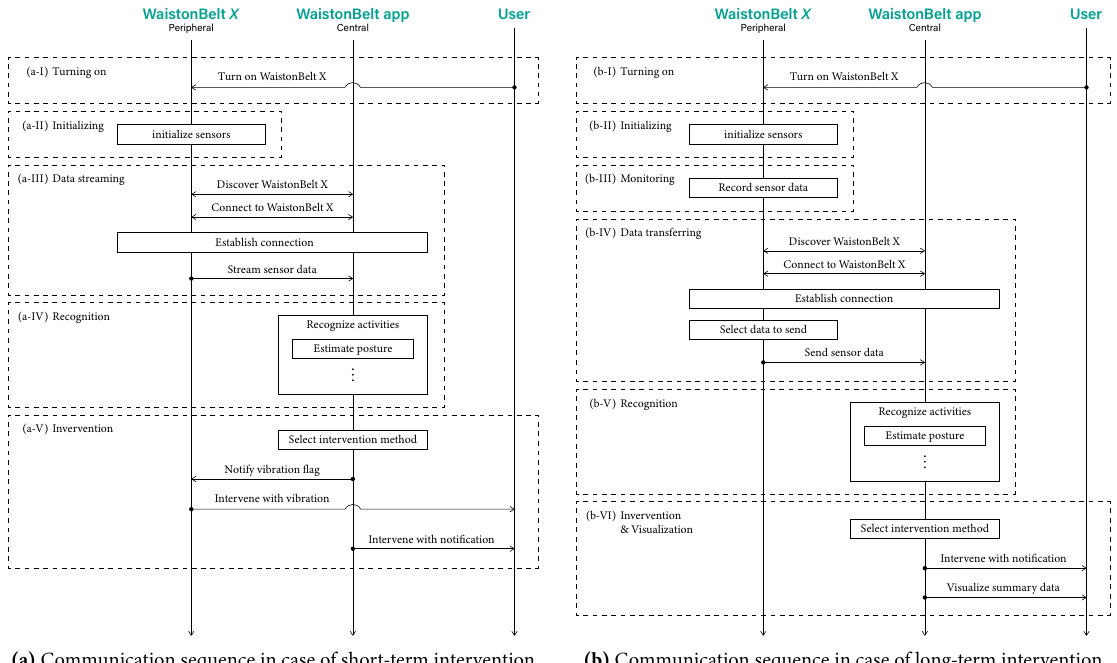
Figure 10. Communication sequence between WaistonBelt X, WaistonBelt app, and